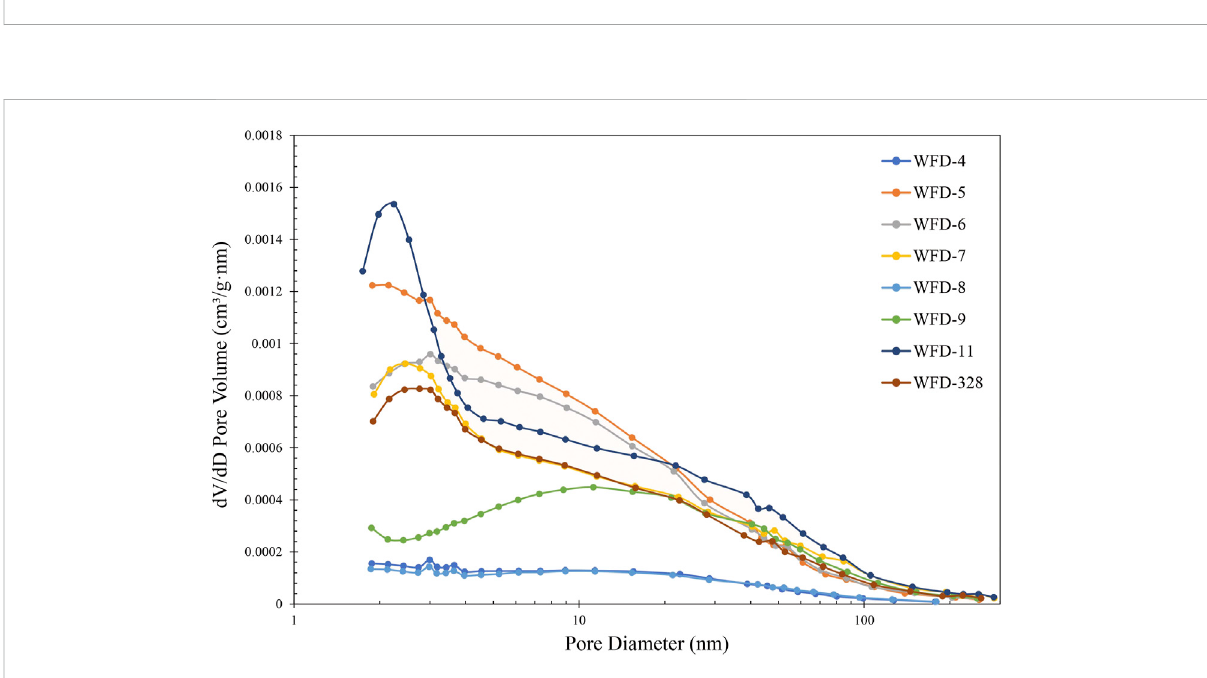
FIGURE 5 Pore diameter distribution from the GP